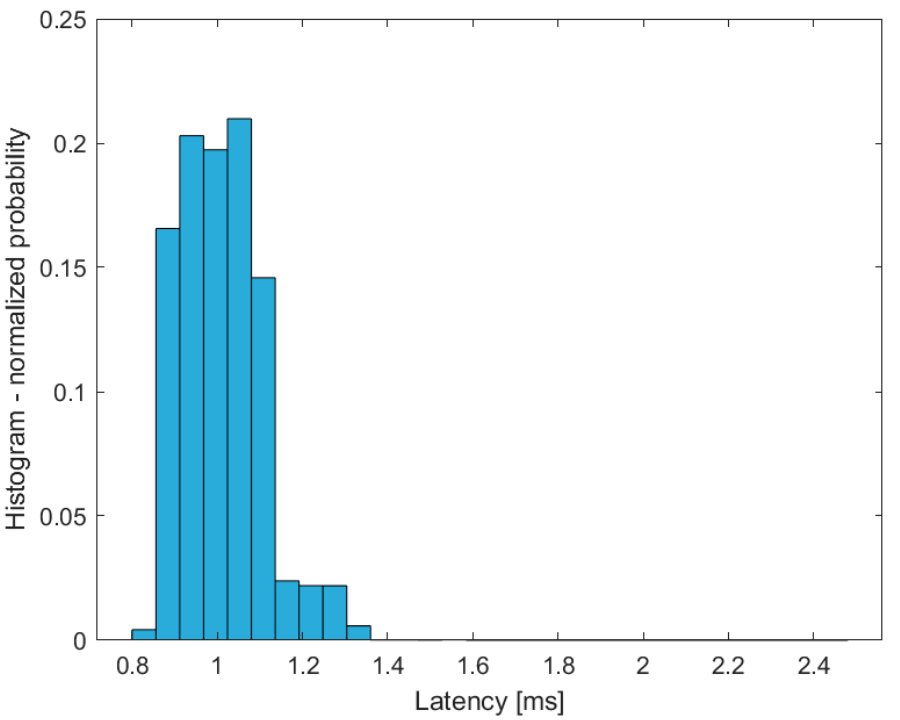
Figure 6. Latency histogram of 100,000 samples on the URLLC testbed with UDP traffic with a payload of 1420 bytes.